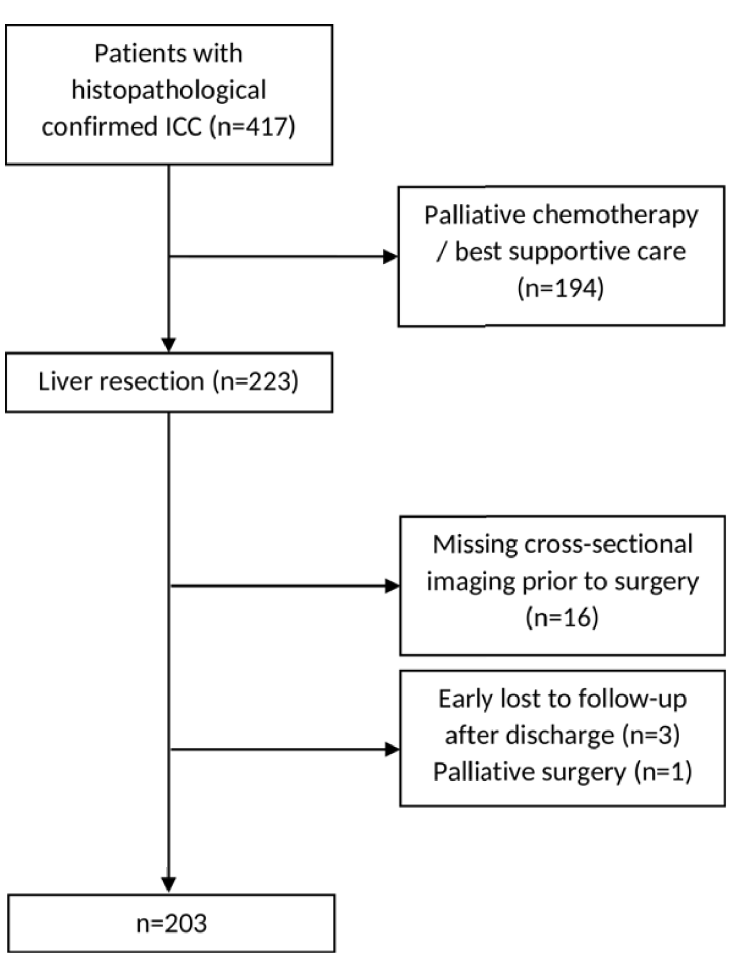
Fig 1. CONSORT flow chart. The reasons for drop-outs and the final number of patients for whom the MEGNA score could be evaluated are shown.